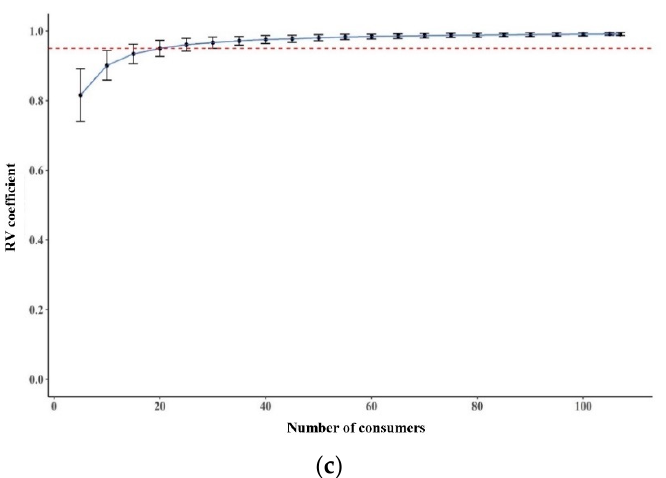
Figure 3. Average regression vector (RV) coefficient of samples in terms of original configuration of samples as a function of the number of consumers considered in the resampled simulated panels for each method. Vertical bars correspond to standard deviations: ( a ) CATA method; ( b ) RATA method; ( c ) CATA-JAR method.